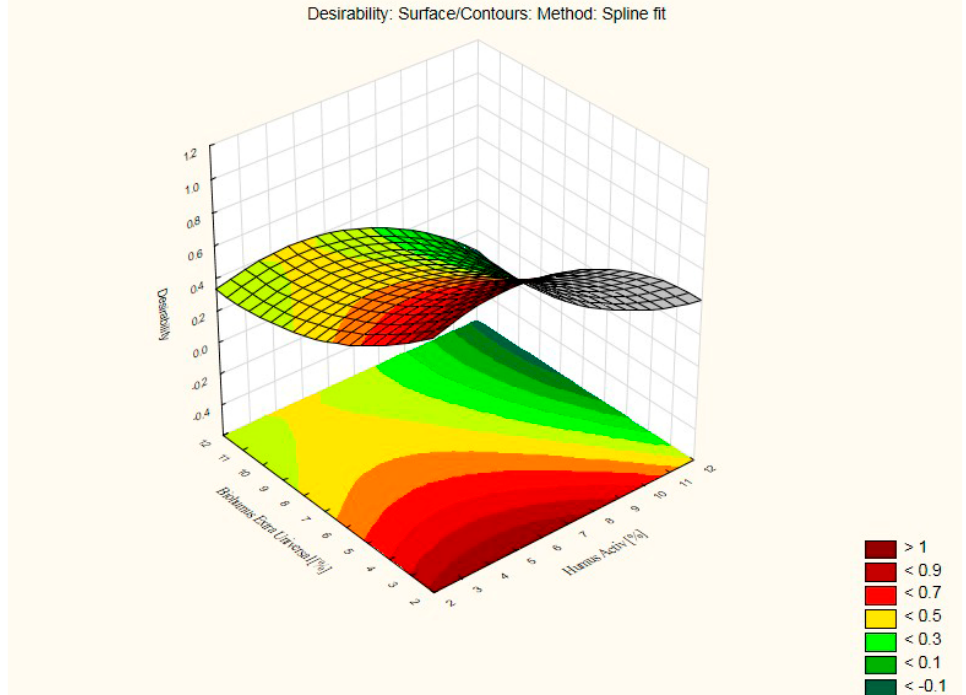
Figure 18. Graph of usability functions and its projection, with points of total usefulness (compressive strength and bulk density) of silicate products with the addition of Humus Activ and Biohumus Extra